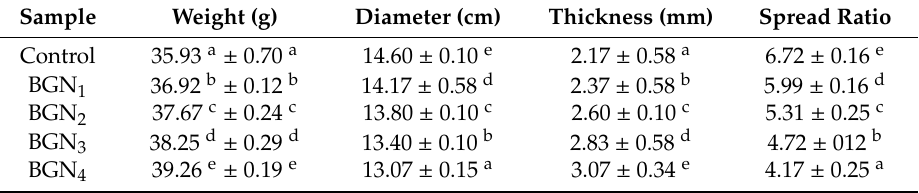
Table 5. Physical characteristics of tortillas added with Bambara groundnut